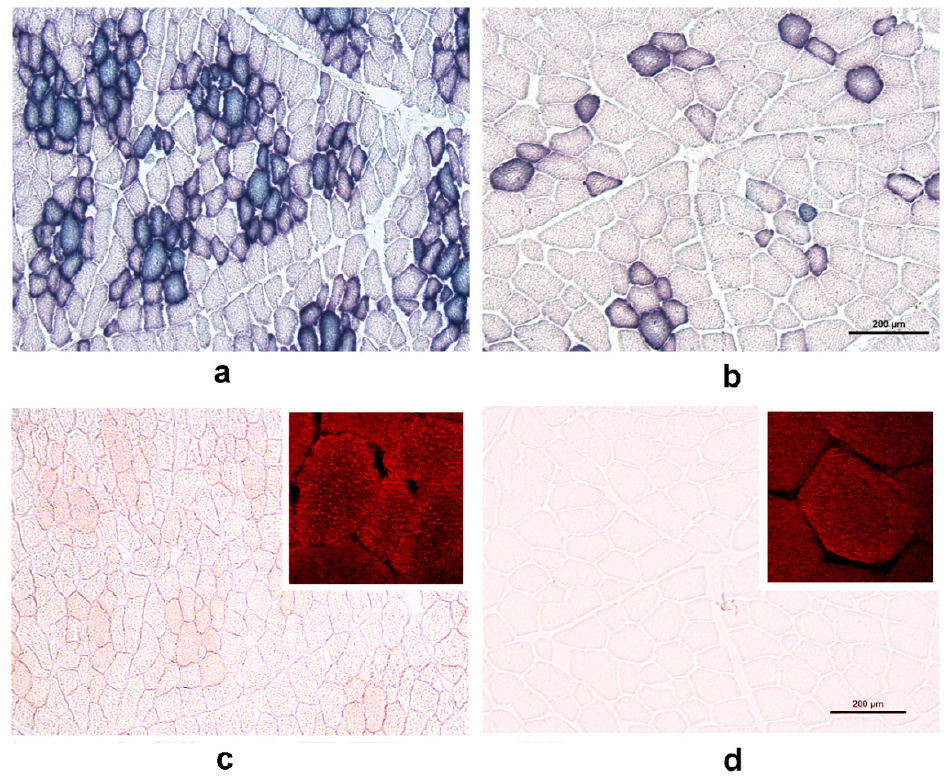
Figure 3. Transverse cryosections of the longissimus dorsi muscle of a 2-year-old wild pig (WP; panels a and c ) and a 2-year-old domestic pig (DP; panels b and d ) were stained for succinate dehydrogenase (SDH) activity (panels a and b ) and the accumulation of neutral lipids within myofibers (using oil red O, panels c and d ). Note that SDH-positive myofibers were more numerous in the WPs than in the DPs ( cf. panels a and b ) and that the SDH activity pattern largely overlapped with intense oil red O staining in the WPs ( cf. panels a and c ). In the DPs, oil red O staining was too faint to analyze the intra-myofiber lipids (IMFLs) (panel d ). The difference in the staining intensity of oil red O-positive fibers between the WPs and DPs was also examined using confocal microscopy (panels c and d ; inserts). Note that fluorescence signals indicative of IMFL droplets (red) were more intense in the WPs than in the DPs. Scale bar = 200 μ m (also valid for the WPs).